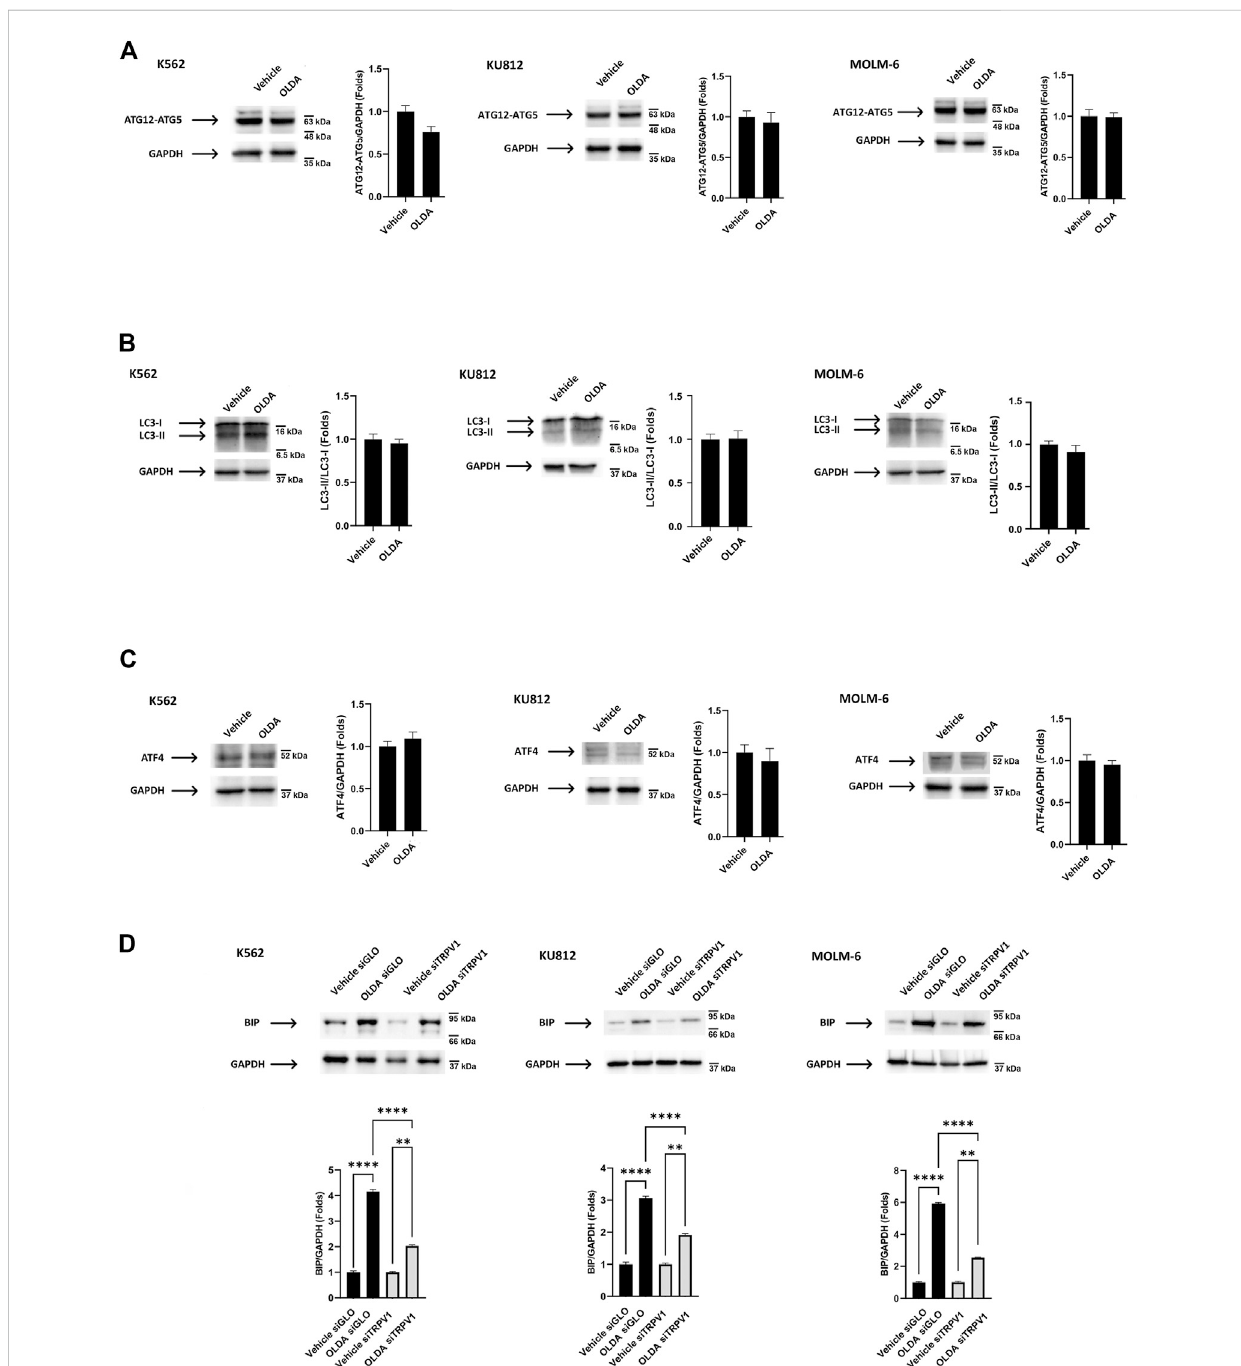
FIGURE 3 TRPV1 activation by OLDA promotes ERstress in CML cells. (A, B) Westernblot analysis of theATG12 – ATG5 complex (A) , LC-3 II (B) , and ATF4 (C) in CML cells treated with OLDA at the IC 50 dose for 24 h. (D) Western blot analysis of BiP in siGLO and siTRPV1 CML cells treated as previously described. Blots are representative of three experiments. GAPDH was used as the loading control. Folds (mean ± SD of three experiments) = changes compared to the vehicle. ** p < 0.01; **** p <